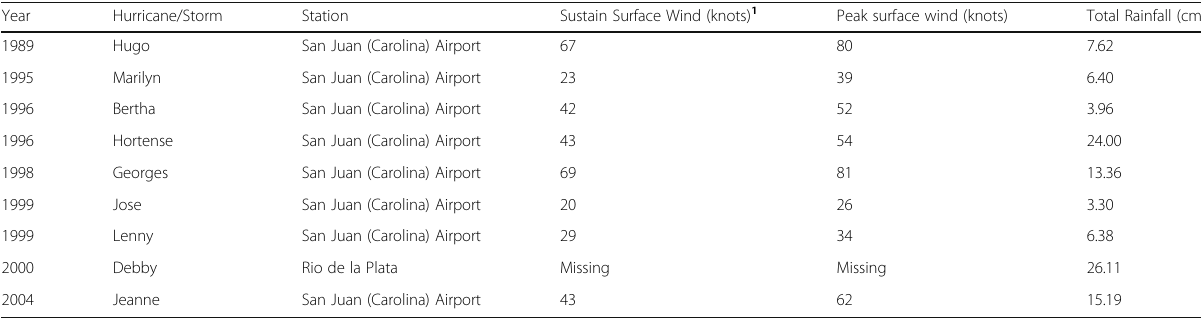
Table 1 Hurricanes and storms that struck JB-BN during our study (1997 – 2005) and for the 10 years prior to the